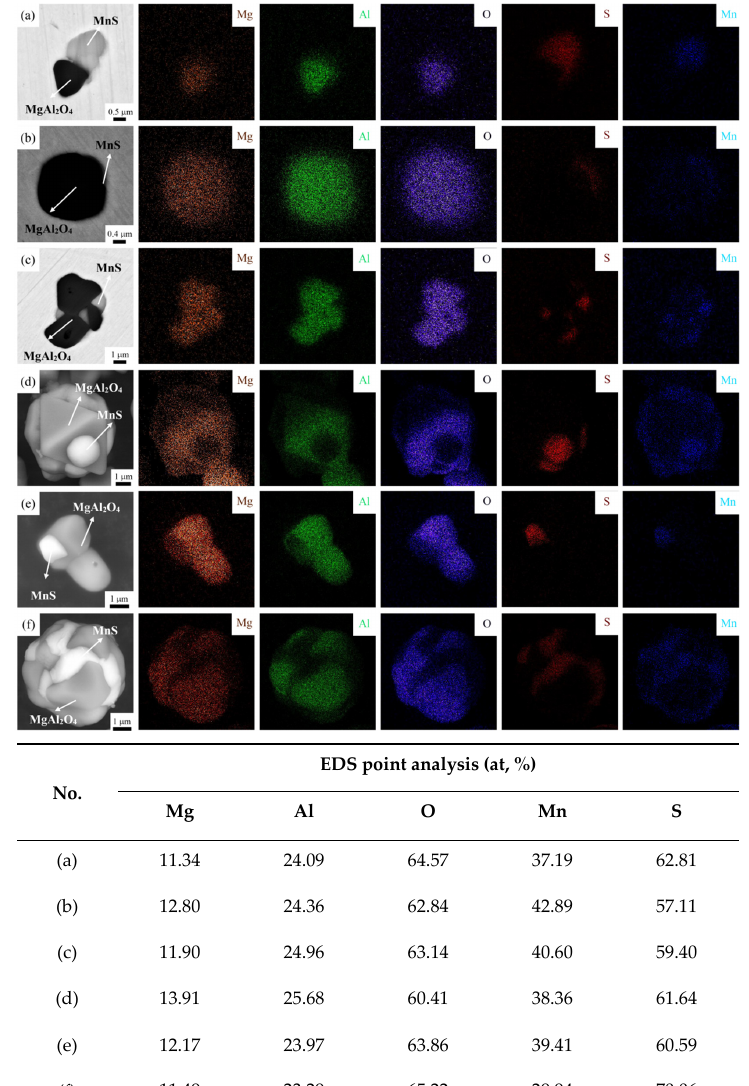
Figure 5. 2D, 3D morphologies, and elements mappings of MgAl 2 O 4 ‐ MnS composite inclusion. ( a ) Upper and lower structure MgAl 2 O 4 ‐ MnS; ( b ) Spherical MgAl 2 O 4 ‐ MnS; ( c ) Multi ‐ particle MgAl 2 O 4 ‐ MnS; ( d ) Regular octahedron MgAl 2 O 4 with MnS; ( e ) Long ‐ strip MgAl 2 O 4 ‐ MnS; ( f ) Ellipsoidal MgAl 2 O 4 ‐ MnS.